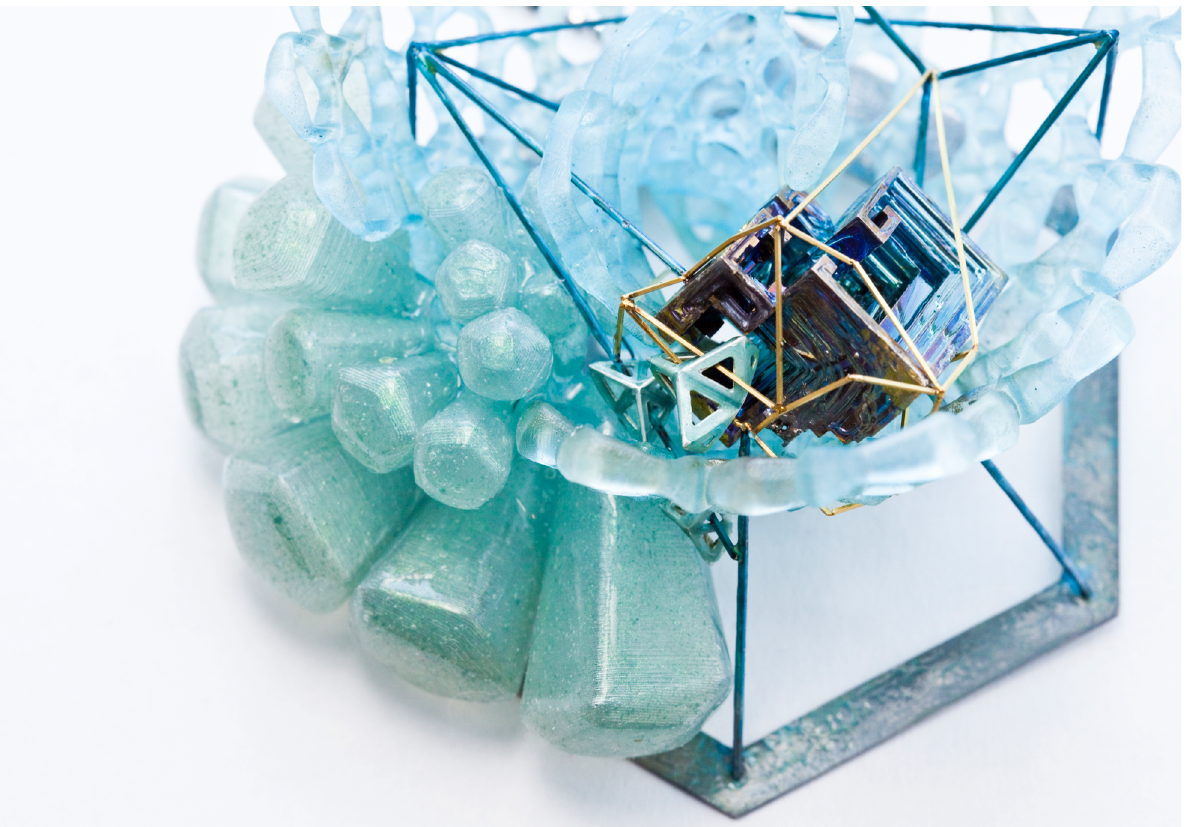
Figure 7 | Ice Crystal Necklace in its unchanged state, Katharina Vones